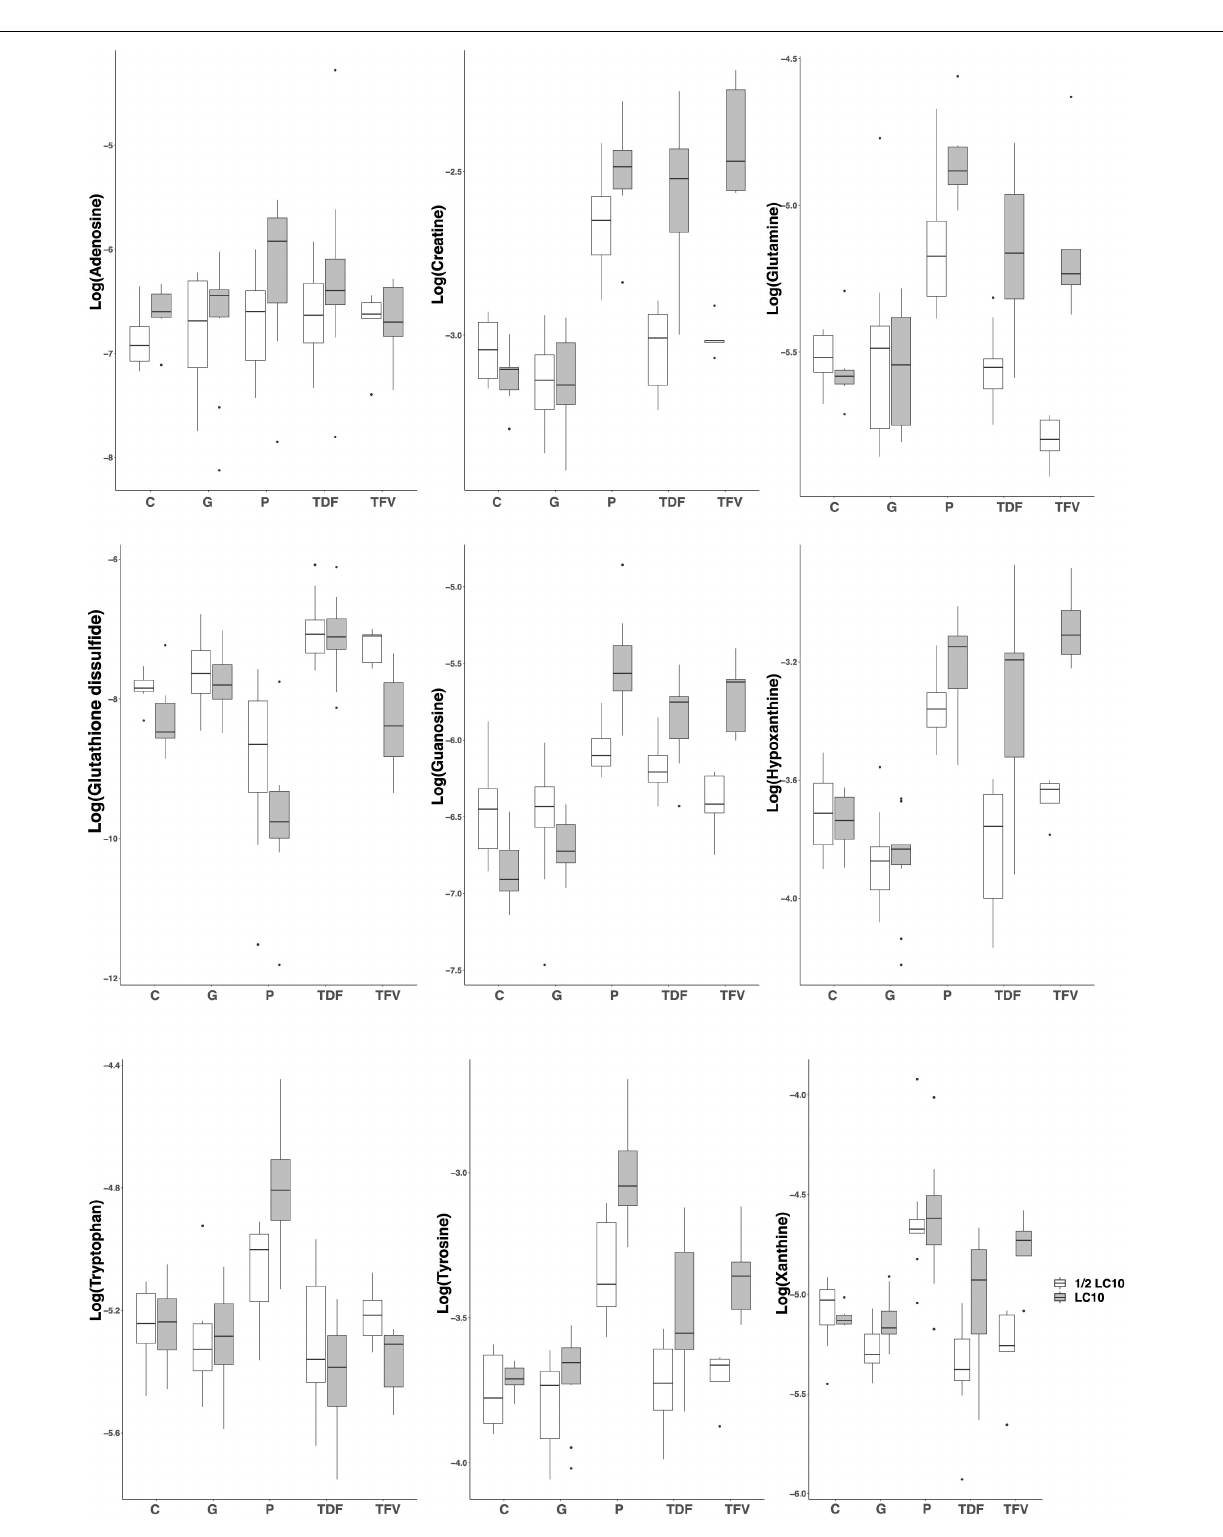
Frontiers in Pharmacology |